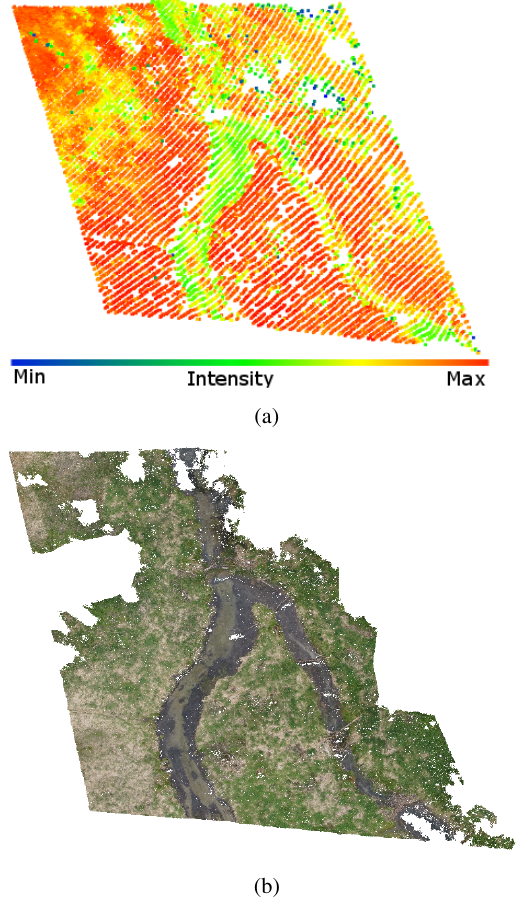
Figure 5. The used point cloud data, a) ALS data b) photogrammetric point cloud generated from the UAV taken